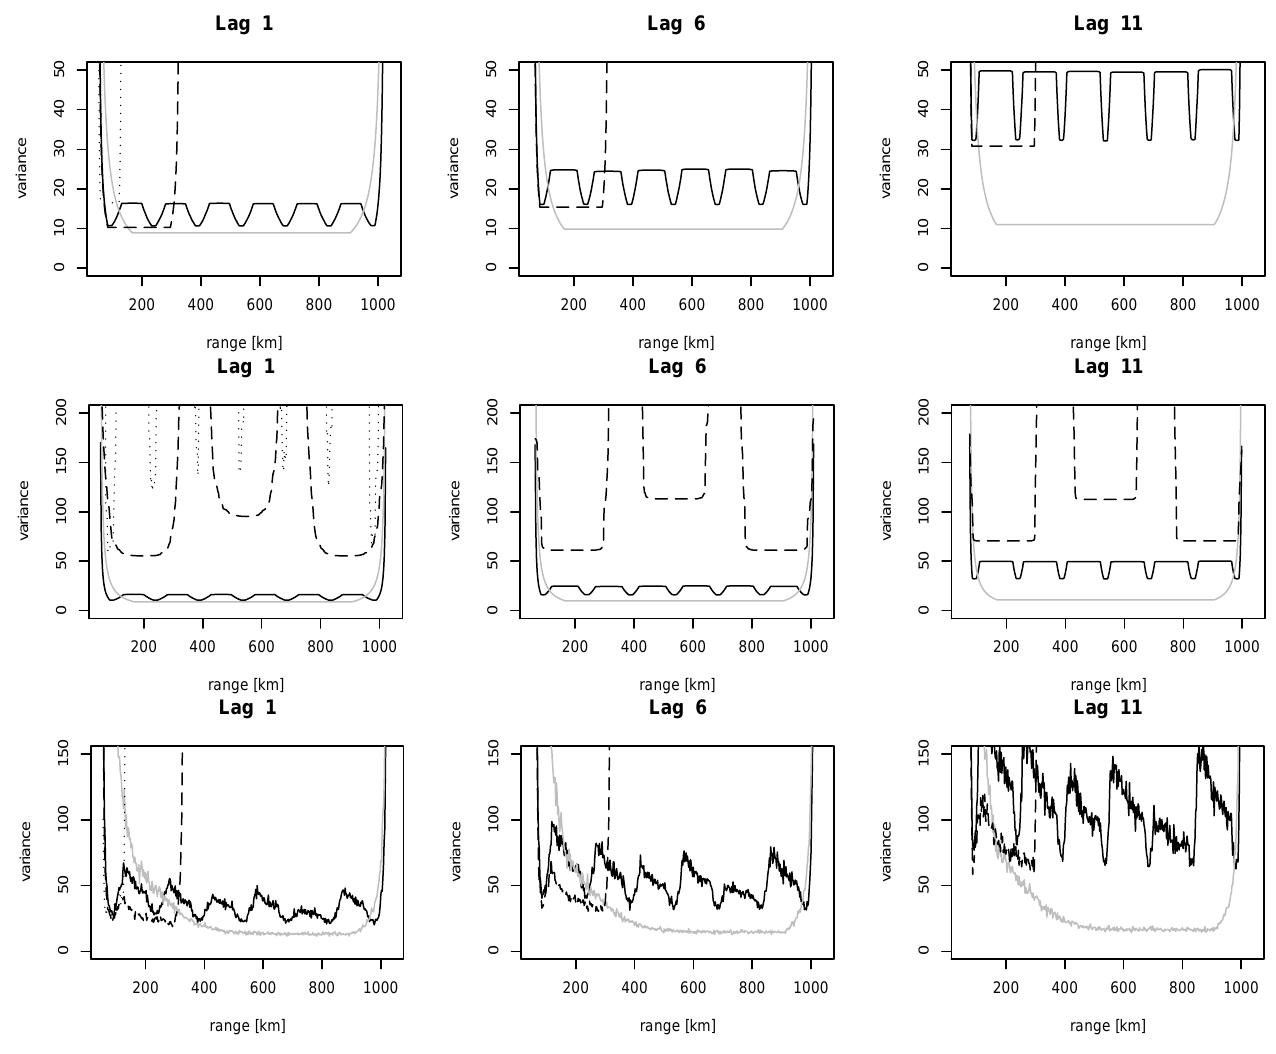
Fig. 5. Top panel: Normalised variances of selected lags under low SNR conditions in the compared experiments. The continuous black line is the variance of the PPATC experiment, the grey line is the variance of exp1, the dashed line the variance of exp2 and the dotted line is the variance of exp3. The experiments with uniform IPPs are analysed only up to the range of one IPP. Middle panel: Normalised variances of the compared experiments under low SNR conditions, when the analysis of all four experiments is extended to cover the target range interval of the PPATC experiment. It is clear that the strong type-1 alternating codes used in the experiments do not behave well when analysed this way. Bottom panel: sample variances of the inversion results of simulated data. In total 314 inversion results have been used for each variance